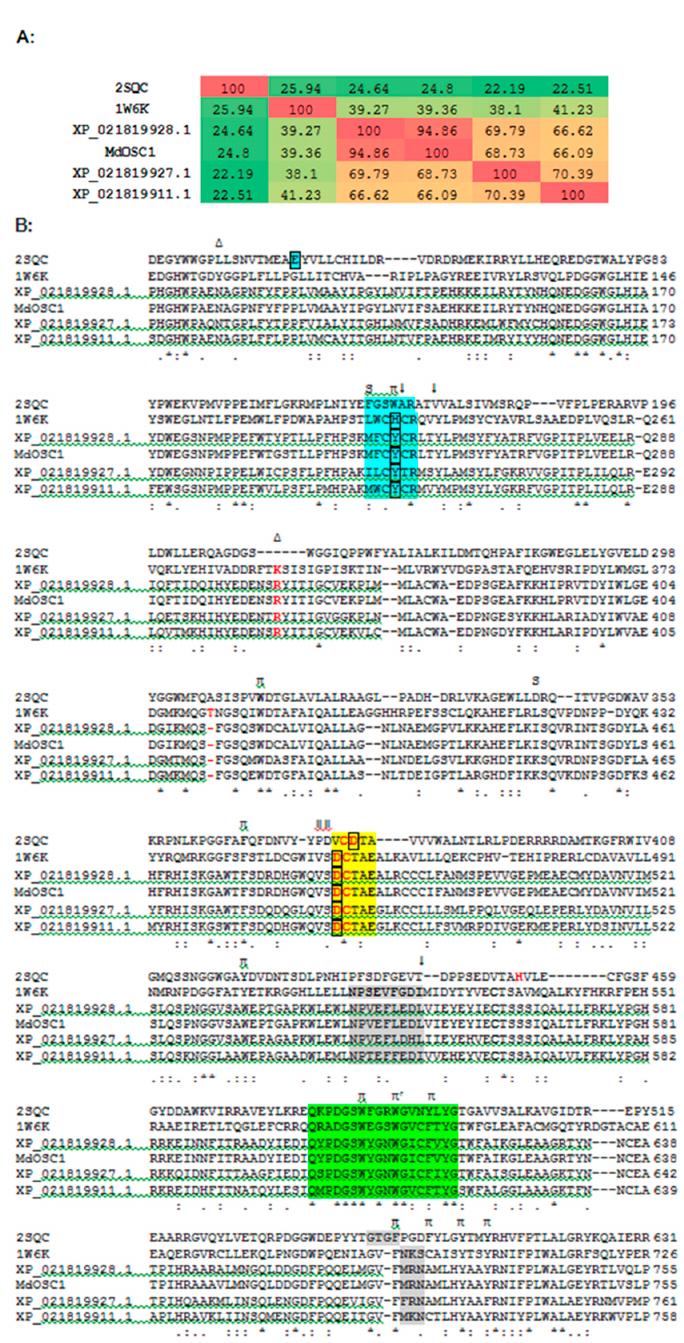
Figure 3. Percentage identity ( A ) and multiple alignment ( B ) of OSCs from fruits, bacteria (2sqc) and human (1w6k). Apple, Cherry9911, 9927 and 9928 indicate MdOSC1, XP_021819911.1, XP_021819927.1 and XP_021819928.1, respectively. Cyan highlighted, conserved M(W / Y)CY(C / S)R motif; yellow highlighted, conserved DCTAE motif; green highlighted, conserved Q-X3-G-X-W-X3-W-G motif; grey highlighted, loops surrounding substrate channel; π , FYWH may be involved in carbocation-pi interactions, whereas π r is used as binding reference in docking experiments; red boxed, Asp involved in the initial protonation of linear substrate; red Cys / His, H-bonding partners of Asp involved in increasing their acidity; cyan boxed, involved in deprotonation of the cyclic substrate at the end; ↓ , substrate entry; ∆ , may be involved in steric deformation; || , may be involved in correct substrate orientation (Asp in 2SQC; Val in all others); S, product specificity. Unimportant sequence blocks have been